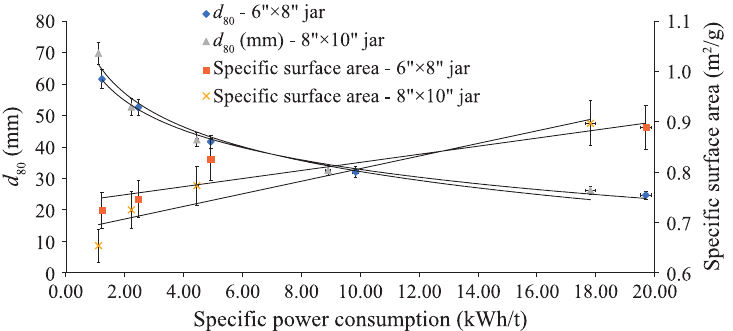
Fig. 5 Specific power consumption as a function of d 80 and specific surface area—Vale Sossego sample 1.